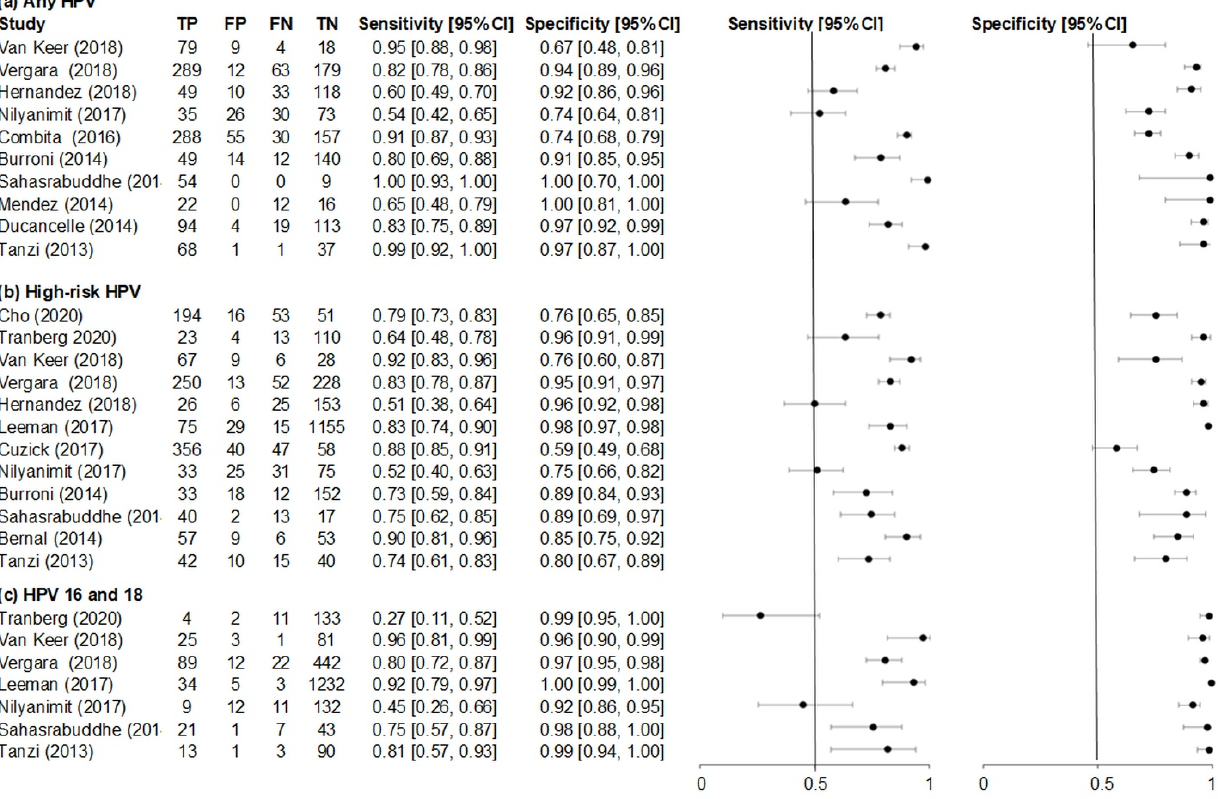
Figure 3. Forest plots of ( a ) any HPV, ( b ) high-risk HPV and ( c ) HPV 16 and 18 sensitivity and specificity for studies evaluating accuracy of first-void urine human papillomavirus (HPV) detection compared to cervical HPV.